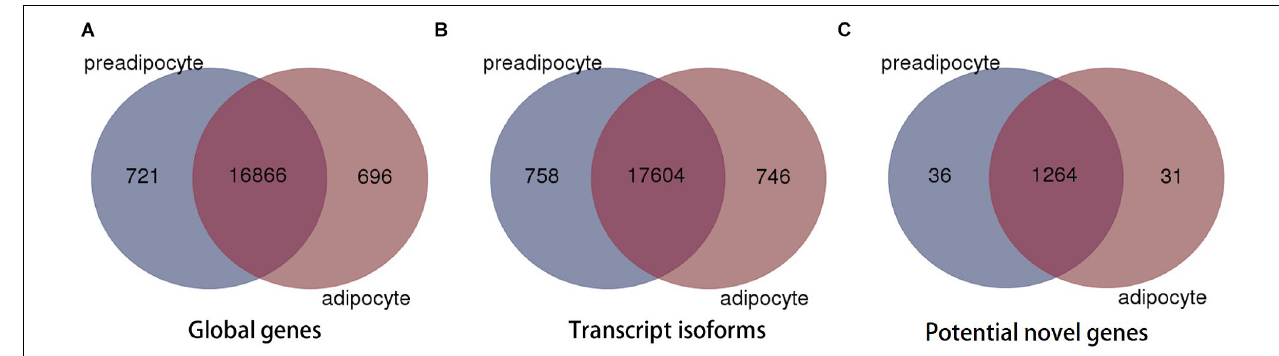
FIGURE 1 | Venn diagram of global genes (A) , transcript isoforms (B) , and potential novel genes (C) .